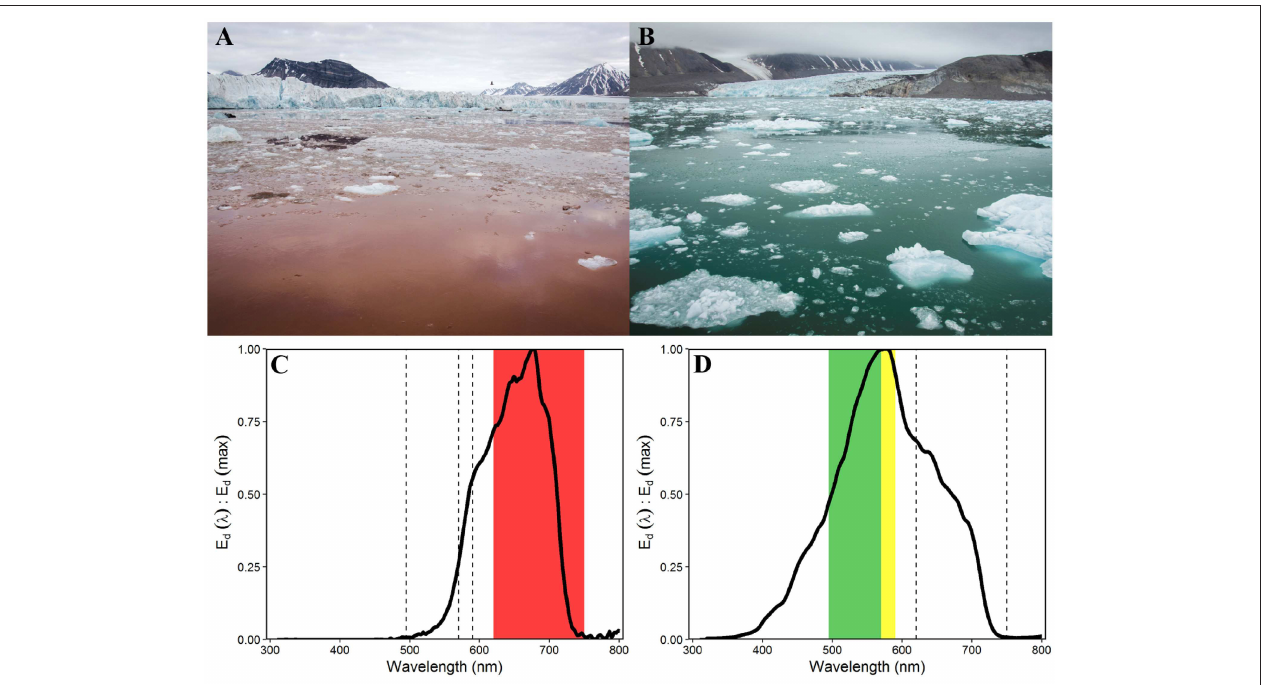
FIGURE 5 | Contrasting water colouration in the Southern Glacier Zone (A) and Northern Glacier Zone ( B , photo shows Conwaybreen glacier front), due to different sediment loads and characteristics (photos: Laura Halbach). Normalised spectral irradiance E d ( λ ) at 2m water depth at 685m distance to Kronebreen (C) and at 375m distance to Conwaybreen (D) (E d (PAR) 0.1 and 48.2 µ mol photons m − 2 s − 1 , respectively) with maximum downwelling irradiance in red (620–750nm), green (495–570nm), and yellow (570–590nm) wavelengths,